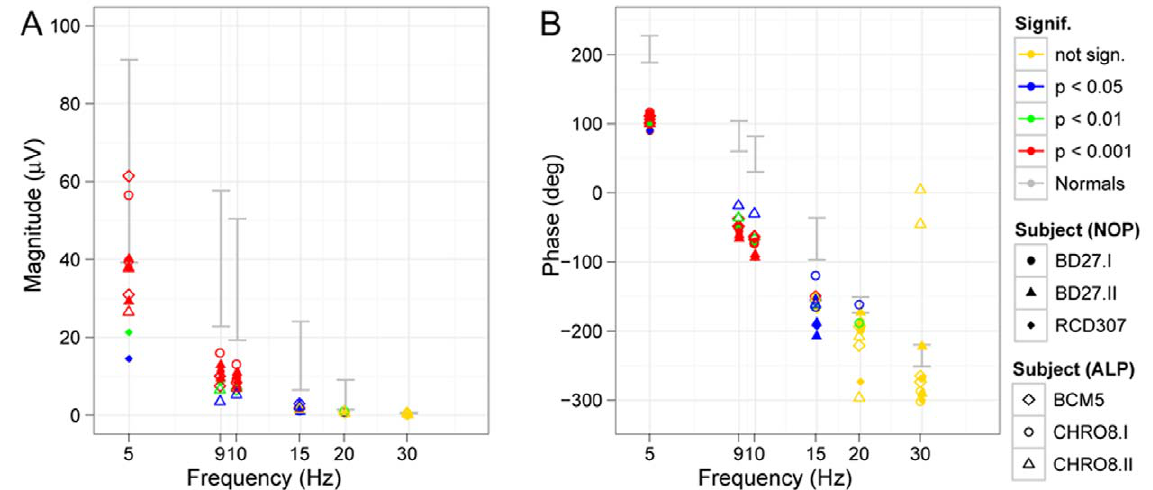
Figure 7. Scotopic flicker series. Magnitude (A) and phase (B) of scotopic flicker responses to stimuli of increasing flicker frequency are presented. Significance levels are color-coded in each figure, the 95% confidence band of normal subjects are marked with grey. The amplitudes of the patients are below normal and not significant for stimuli faster than 15 Hz. The phase shift, however, seems to be independent from flicker frequency.